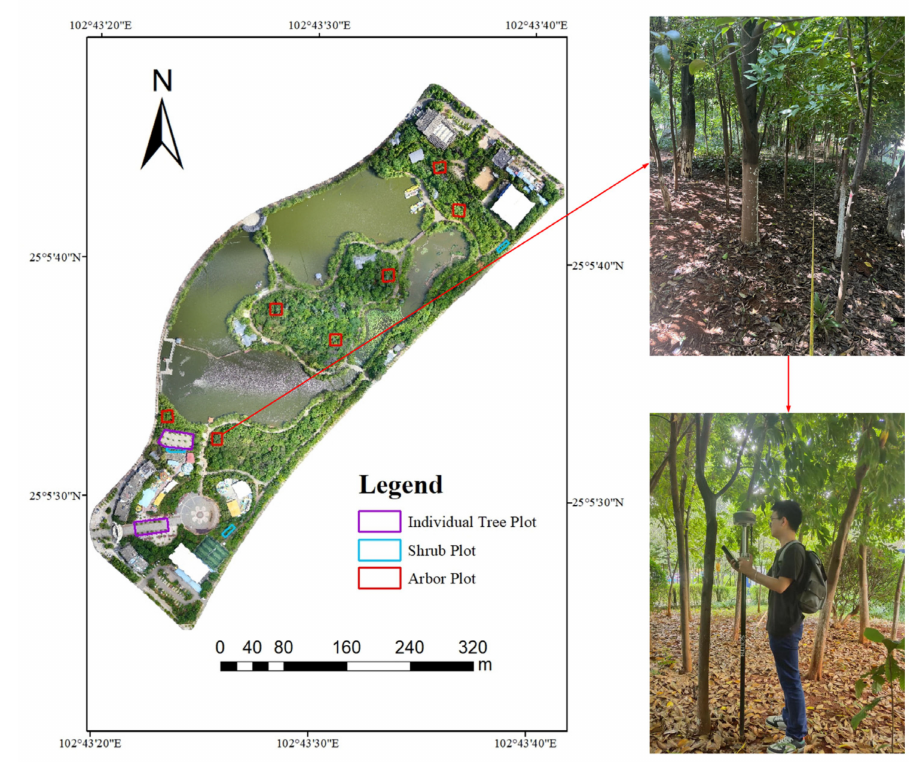
Figure 3. The plots in YueYaTan Park. Table 3. The 3DGV Calculation Equations of Different Tree Species.